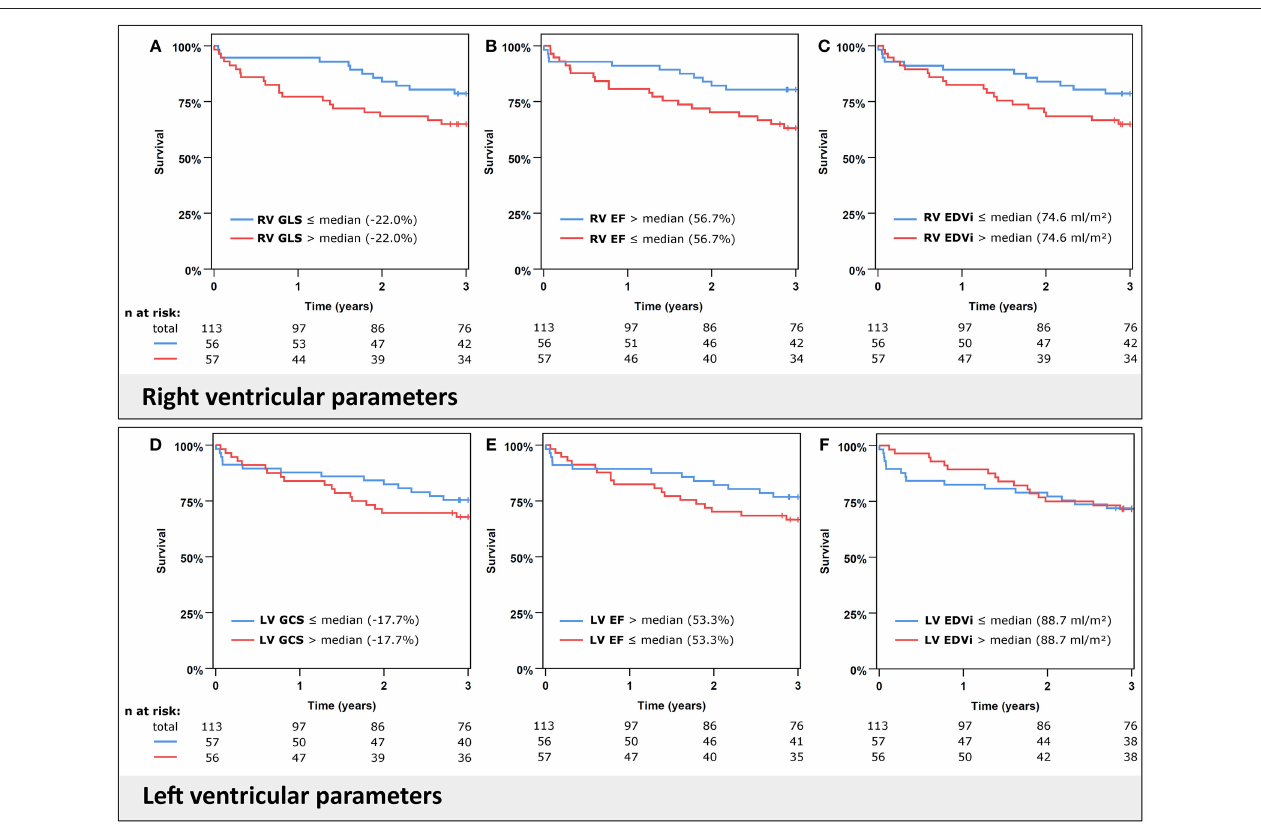
FIGURE 3 | Kaplan–Meier plots for all-cause mortality. Cumulative survival according to right ventricular (RV) global longitudinal strain (GLS) (A) , ejection fraction (EF) (B) , end-diastolic volume index (EDVi) (C) in the upper panels and left ventricular (LV) global circumferential strain (GCS) (D) , EF (E) , and EDVi (F) in the lower panels. Variables are stratified by their